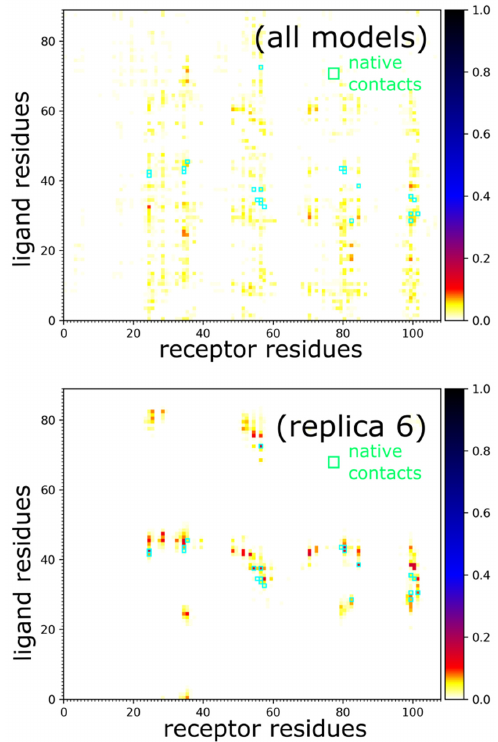
Figure 5. Characterization of barnase/barstar contacts. Panels show barnase/barstar models and contact maps for entire simulation (all models, 10,000 models) and single selected replica (replica 6, 500 models) that reached a near-native arrangement. In the maps, green circles mark the native contacts.